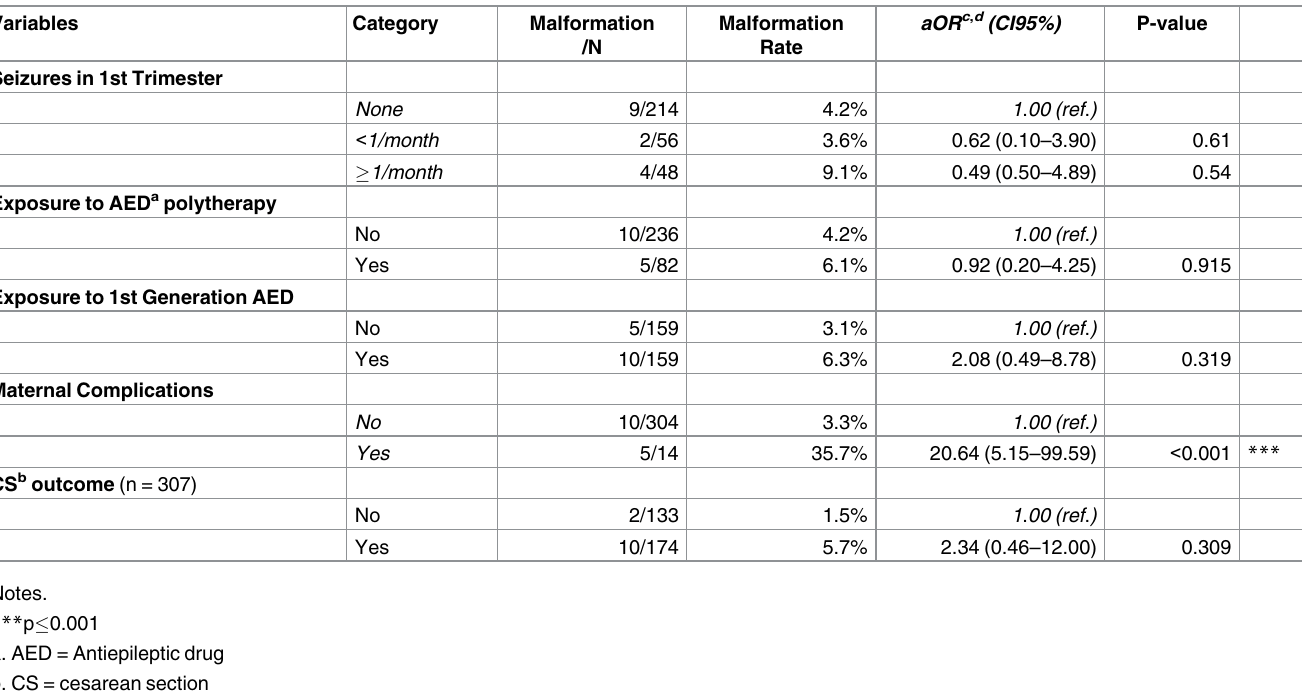
Table 4. Associated factors with malformation rate among WWE pregnancies, n =